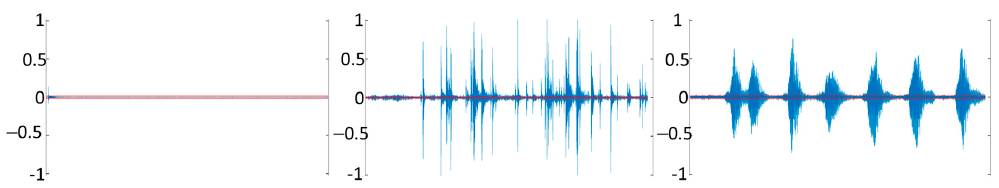
Figure 8. GUI of sound recognition. Table 3. Evaluation of microphone.